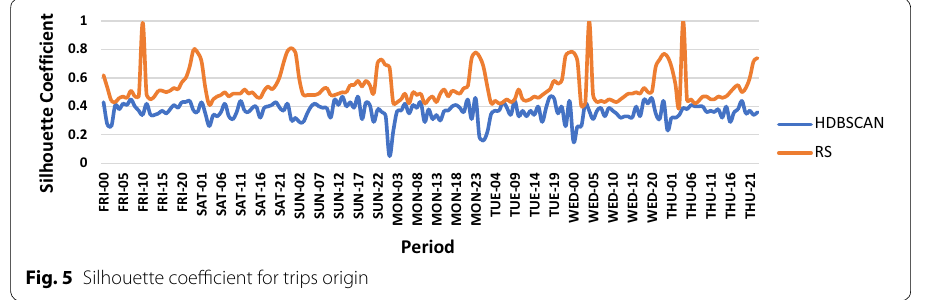
Fig. 5 Silhouette coefficient for trips origin